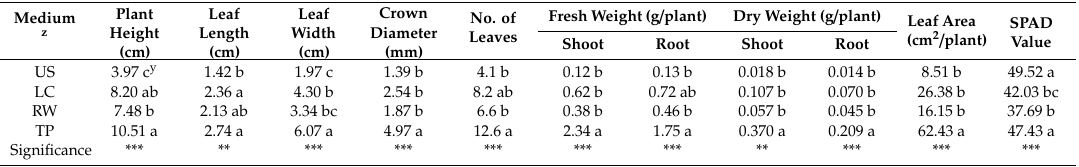
Table 2. The growth characteristics of Adenophora triphylla var. japonica Hara seedlings as a ff ected by di ff erent media at 54 days after transplanting (n = 3).